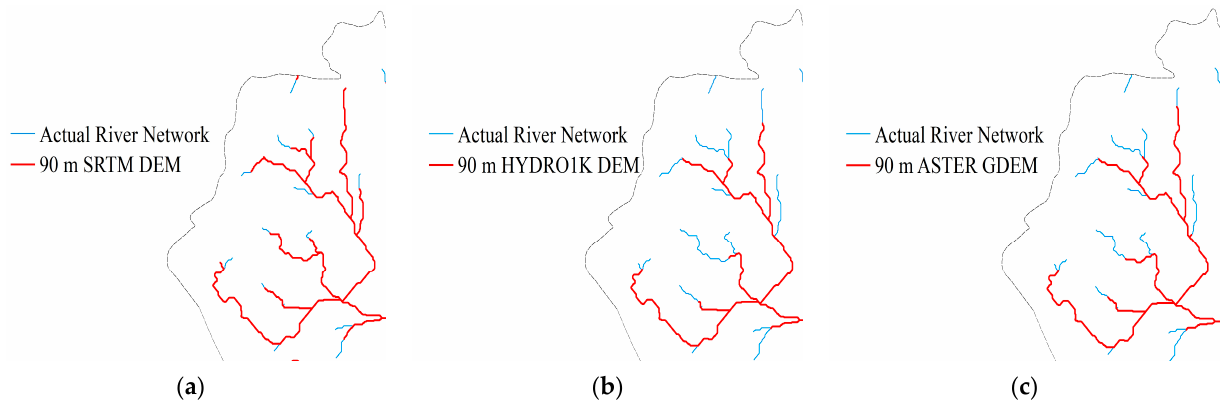
Figure 6. Effect of overlaying 3 kinds of DEM data sources. ( a ) SRTM V4.1 DEM. ( b ) HYDRO1K DEM. ( c ) ASTER GDEM.